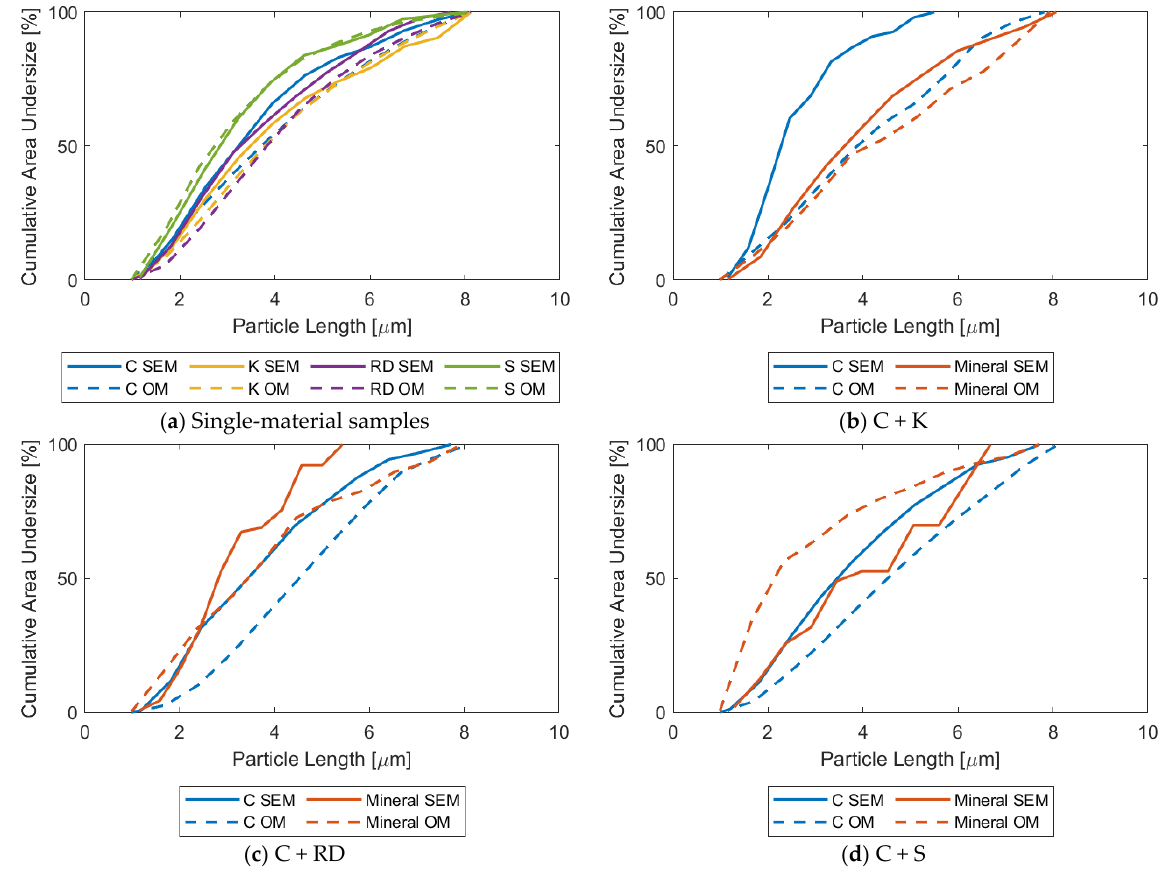
Figure 9. CPSD for coal and mineral particles identified in ( a ) single-material samples and ( b – d ) composite samples.